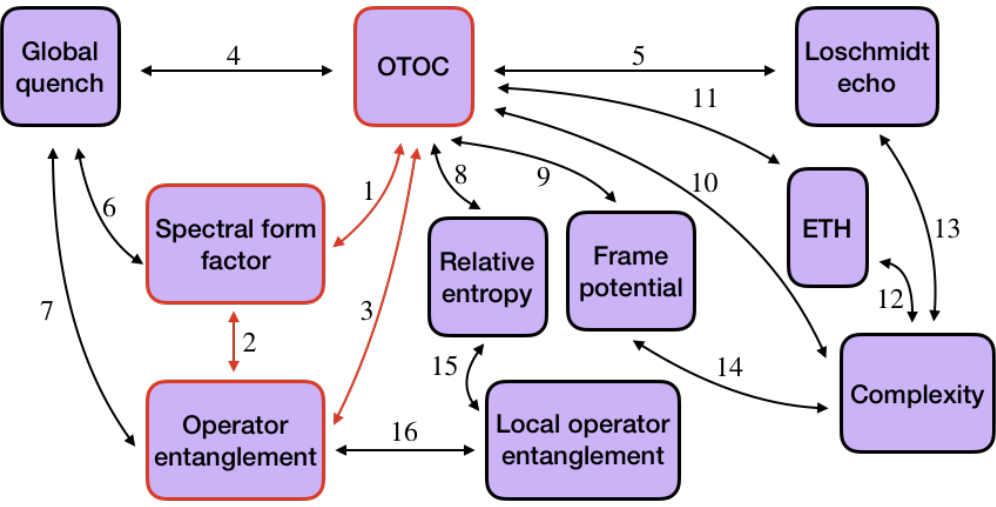
Figure 1 . We lay out a web of chaos diagnostics. In this paper, we focus on the three highlighted in red. The numbered connections have been studied as follows: (1{3) Related in this paper through analytic continuations of the torus partition function. (1) Higher point OTOCs were related to higher-point spectral form factors in ref. [8] and averaged OTOCs were further equated with the SFF in quantum (cid:12)eld theory in refs. [9, 10]. (3) In spin systems, the R(cid:19)enyi operator mutual information is also directly related to the average OTOC [11]. (4,6{7) R(cid:19)enyi entropy of disjoint intervals after a global quantum quench may also be computed by a particular analytic continuation of the torus partition function [12], though we do not focus on this in this paper. (5) The OTOC was equated with the thermally averaged Loschmidt echo in refs. [13, 14]. This was further explored in ref. [6]. (8) The relative entropy of perturbed thermal states was related to OTOC in ref. [15]. (9) 2 k -point OTOCs were equated with k th frame potentials in ref. [16]. (10{12) The rate of growth of Lanczos coe(cid:14)cients, a notion of operator complexity was shown to bound the Lyapunov exponent of OTOCs in ref. [17]. Both the bounds on this rate and the Lyapunov exponent were shown to follow from the eigenstate thermalization hypothesis in ref. [18]. (13) The circuit complexity was suggested to be related to the logarithm of the Loschmidt echo in ref. [6]. (14) The frame potentials were shown to bound the circuit complexity in ref. [8]. (15{16) The entanglement content of a Heisenberg time-evolved local operator may be shown to be related to relative entropy of